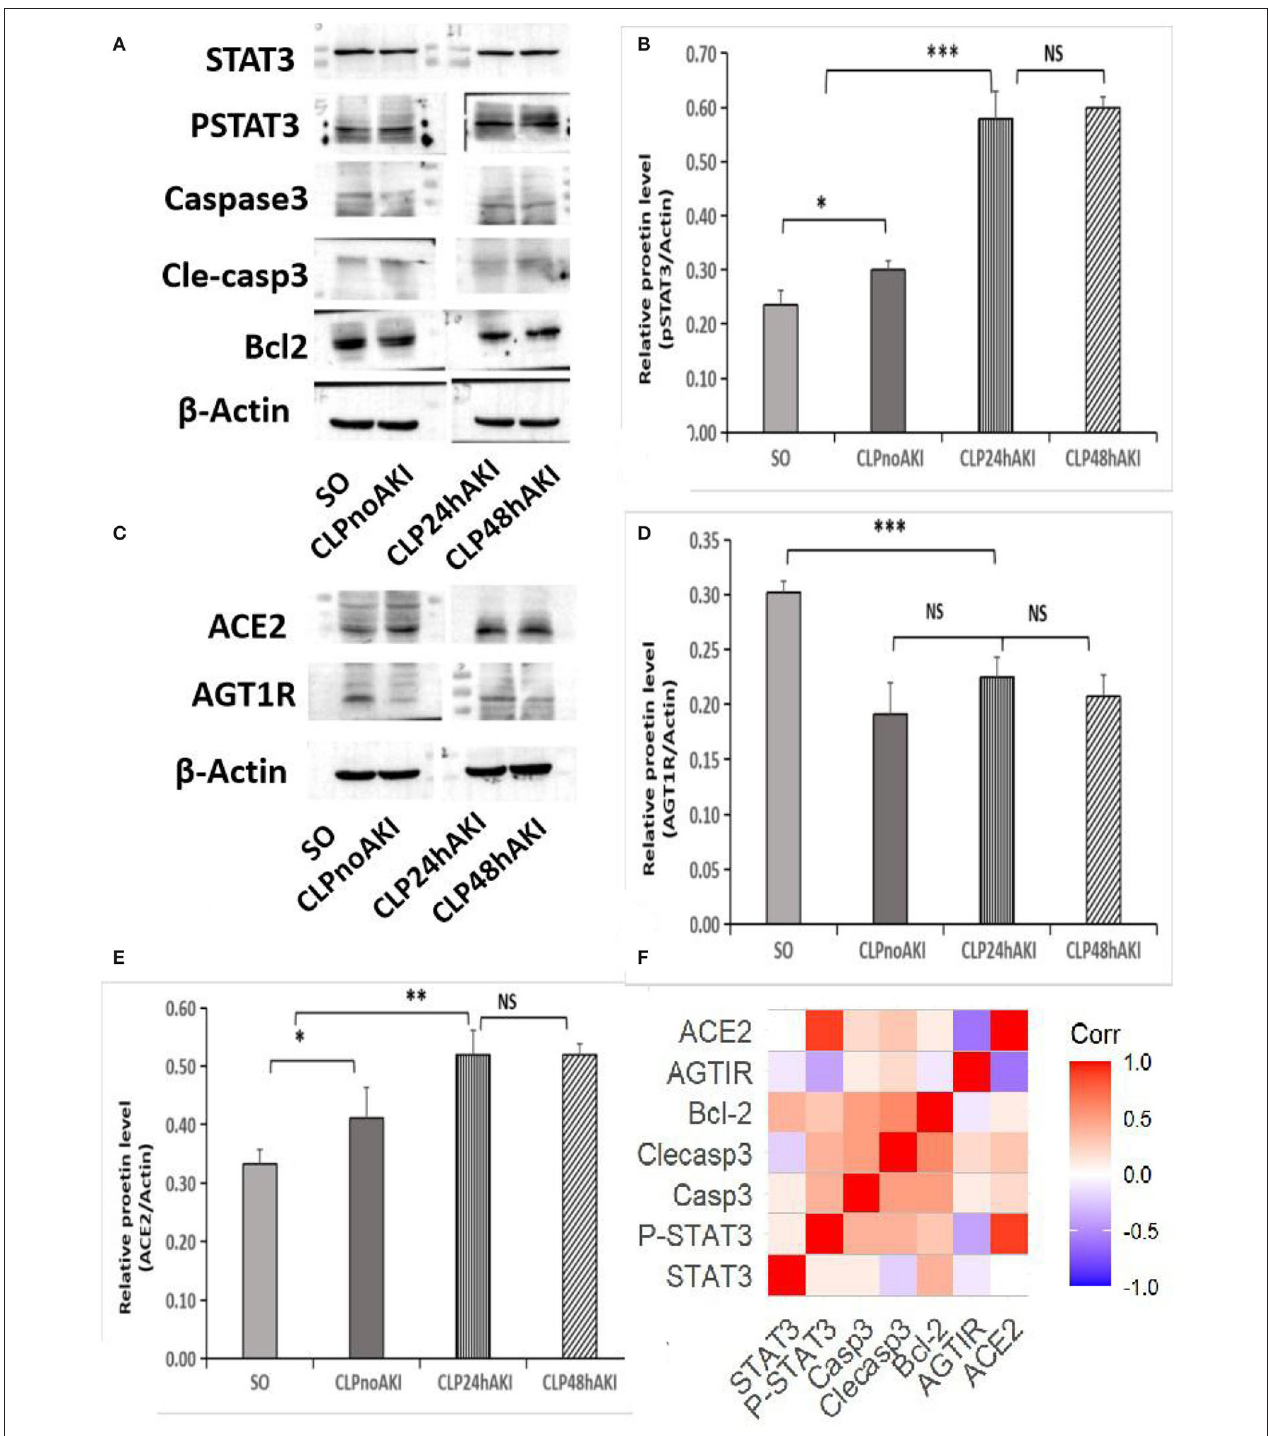
FIGURE 4 | Increased expressions of pSTAT3 and ACE2 were associated with SIAKI. (A) Western blot analyses of STAT3, pSTAT3, Caspase 3, cleaved-caspase 3, Bcl-2 and b-actin levels in renal cortex tissues of SO and CLP mice. (B) Relative pSTAT3 levels in each group. (C) Western blot analyses of ACE2 and AGT1R expression. (D) Relative AGT1R levels in each group. (E) Relative ACE2 levels in each group; (F) Correlations of proteins expression in CLP mice. pSTAT3 level positively correlated with ACE2 expression ( R = 0.874, p < 0.001). Significant relations between 2 factors are highlighted. STAT3,signal transducer and activator of transcription 3; pSTAT3, phosphorylated STAT3; Casp3, caspase3; Clecasp3, cleaved-caspase3;Bcl-2,B-cell lymphoma-2; AGT1R, Angiotensin II Type 1 Receptor; ACE2, angiotensin converting enzyme 2. *, p < 0.05; **, p < 0.01; ***, p < 0.001.